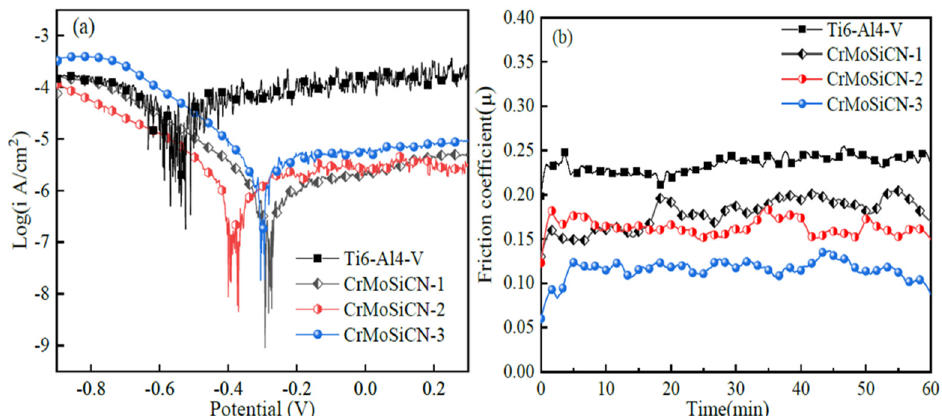
Figure 3. The effects of potentiodynamic polarization on the tribocorrosion behaviors of Ti6Al4V and CrMoSiCN coatings as they slide over SiC balls: ( a ) the polarization curves and ( b ) the friction coefficient variation. (Reprinted from Corrosion Science, 165, Y. Fu, F. Zhou, Q. Wang, M. Zhang, and Z. Zhou, Electrochemical and tribocorrosion performances of CrMoSiCN coating on Ti-6Al-4V titanium alloy in artificial seawater, 108385, Copyright (2020), with permission from